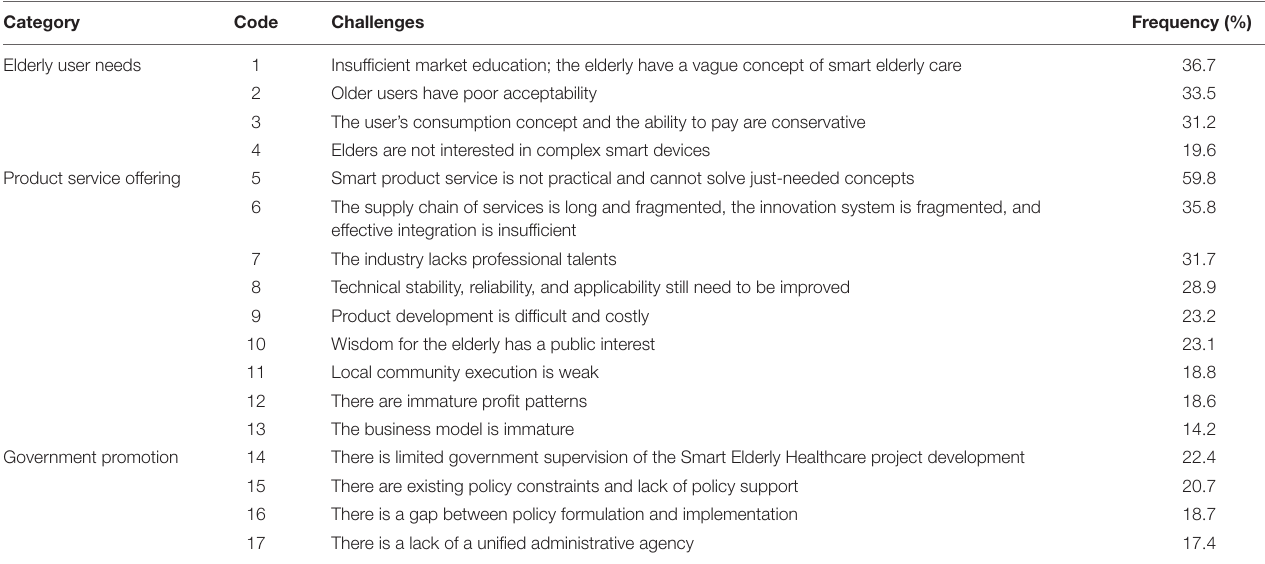
TABLE 5 | Challenges for the Chinese elderly care industry in the smart environment. Category